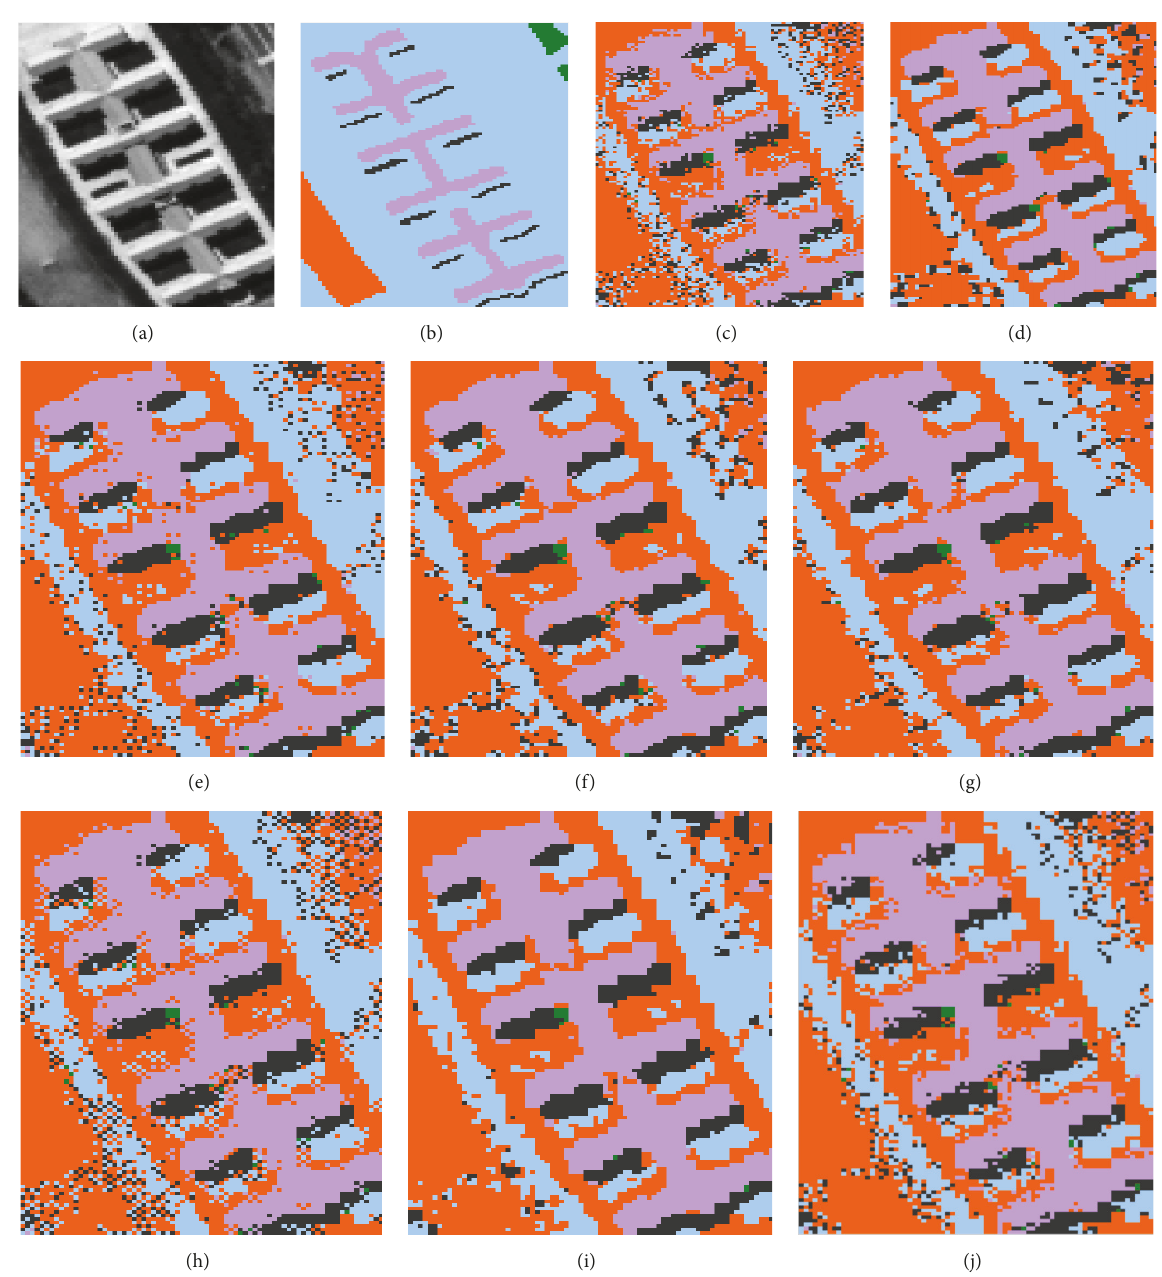
Figure 10: The subpixel mapping results of the PaviaU original subimages: (a) 60th band gray image, (b) true distribution, (c) random distribution, (d) PMBQPSO, (e) CMBQPSO, (f) GMBQPSO, (g) PBQPSO, (h) CBQPSO, (i) GBQPSO, and (j)